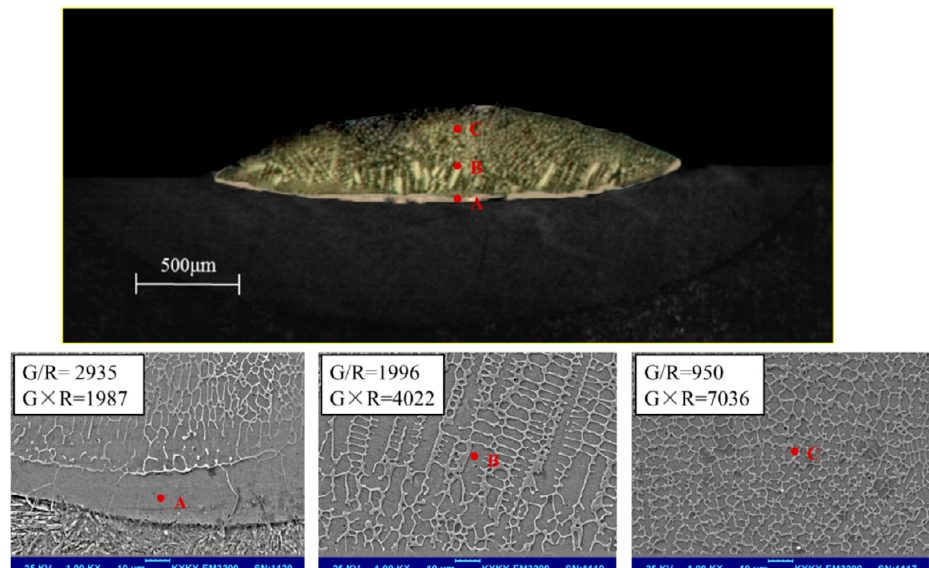
Figure 25. Experimental analysis of microstructure formation during the deposition of a single scan of Co-based alloy on steel. At the bottom of the deposited track (point A), a coarse planar front is observed. In the centre of the track (point B), columnar and coarse dendrite structures are observed. At the top of the track (point C), equiaxed and finer dendrites are obtained (reproduced with permission from [129]; Copyright © 2017 Elsevier).